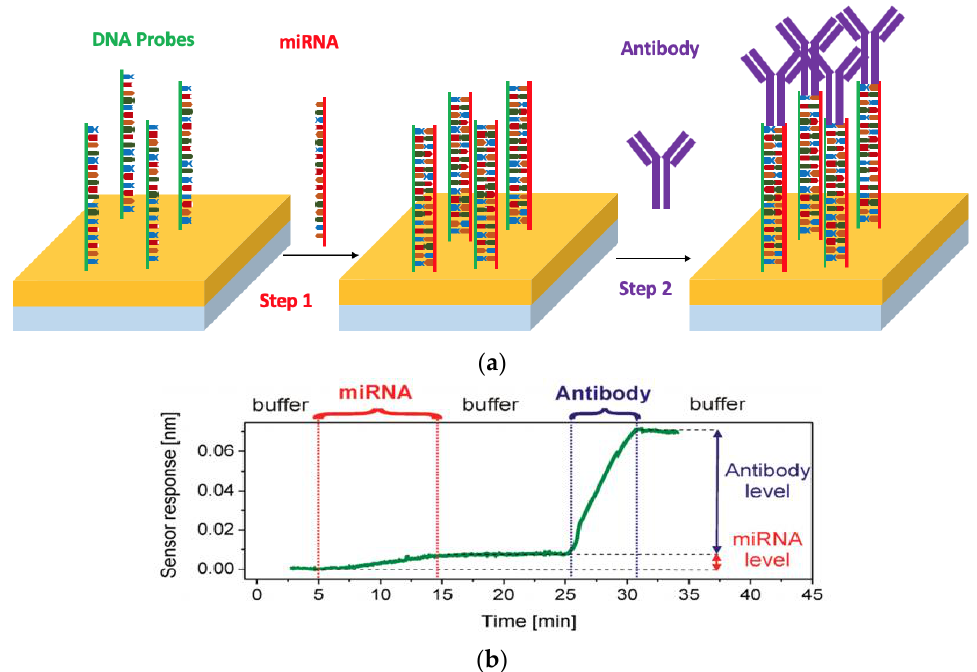
Figure 3. ( a ) Schematic representation of the antibody-based assay for detection of miRNA-122. ( b ) Sensor response to the miRNA and antibody. Reproduced with permission from [71]. Copyright American Chemical Society, 2010.